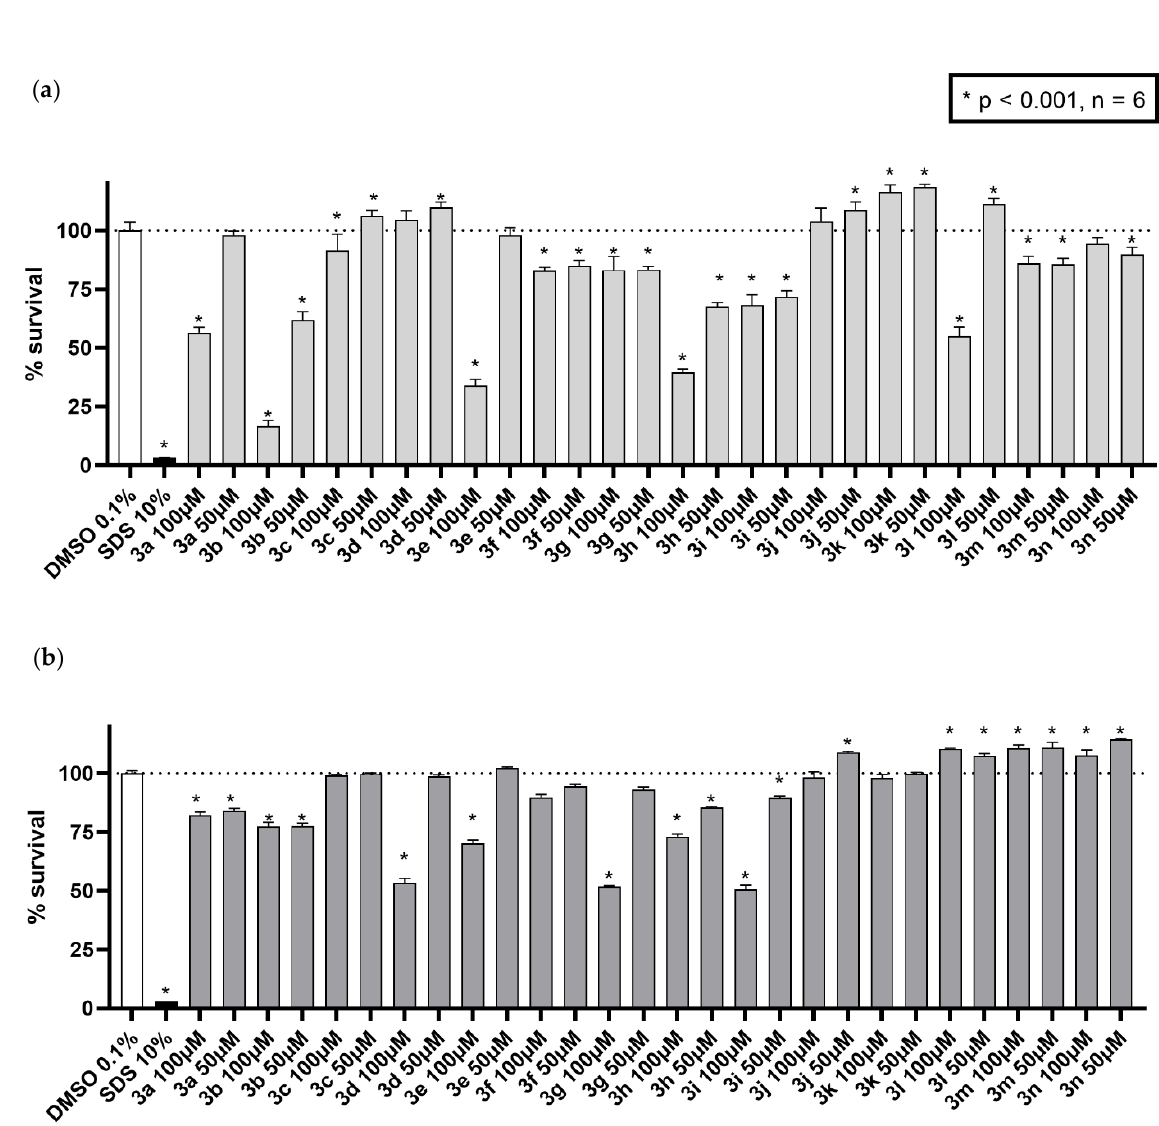
Figure 8. Cytotoxicity activity of the tested compounds. The fourteen derivates were tested in ( a ) breast cancer cell line MCF7/S0.5 and ( b ) renal epithelia HK-2 cell line for 48 h in two high concentrations. Results are expressed as the mean ± s.d. of three independent experiments performed in triplicates, where 100% survival was set to the positive control wells (DMSO 0.1%). Statistical assay one-way ANOVA was performed to assess the significance of the results compared to positive control. * p < 0.001 vs. the negative control DMSO.